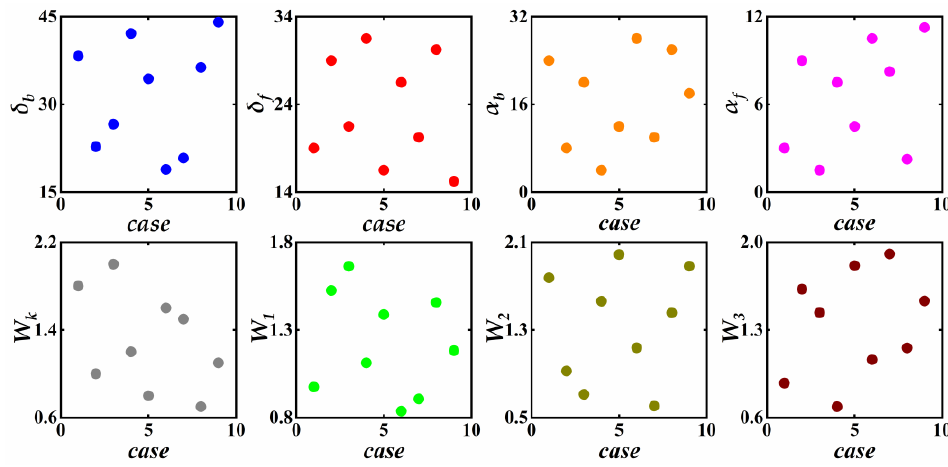
Figure 19. Distribution of design variables in space.